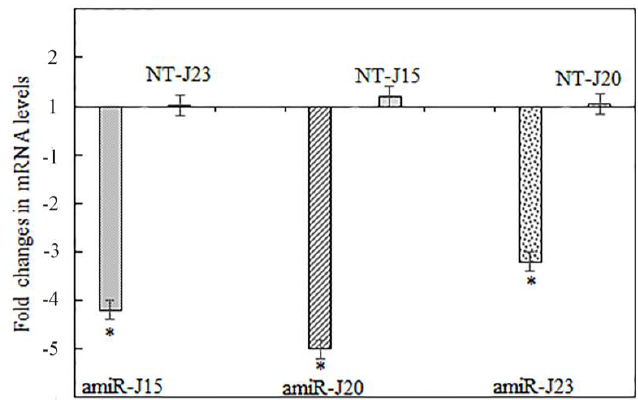
Figure 8. Real-time RT-qPCR results showing the downregulation of target H. glycines genes J15 , J20 , and J23 at mRNA transcript levels by host-derived amiRNA determined at 5 weeks after inoculation. The H. glycines β-actin gene was used as an internal control to normalize gene expression levels among samples. Nematodes feeding on composite plants with the pUFamiR empty vector were used as control samples. The 2 −ΔΔ C t method was used to quantify the relative change in gene expression. The relative expression of a nontarget (NT) parasitism gene in each experiment remained unchanged. Error bars represent the standard error mean between three independent bioassay replicates. * p < 0.05